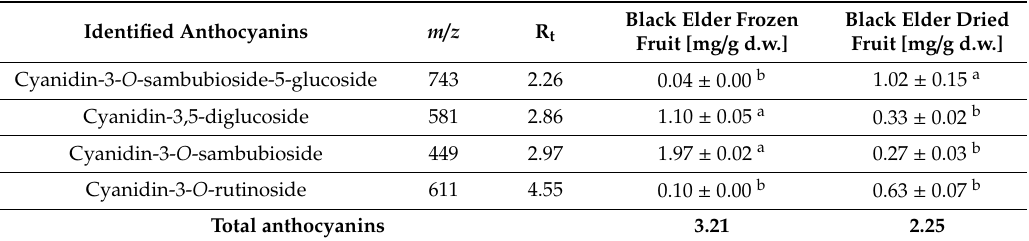
Table 2. Identified anthocyanins and their quantities in the frozen and dried back elder fruits. Identified Anthocyanins m / z R t